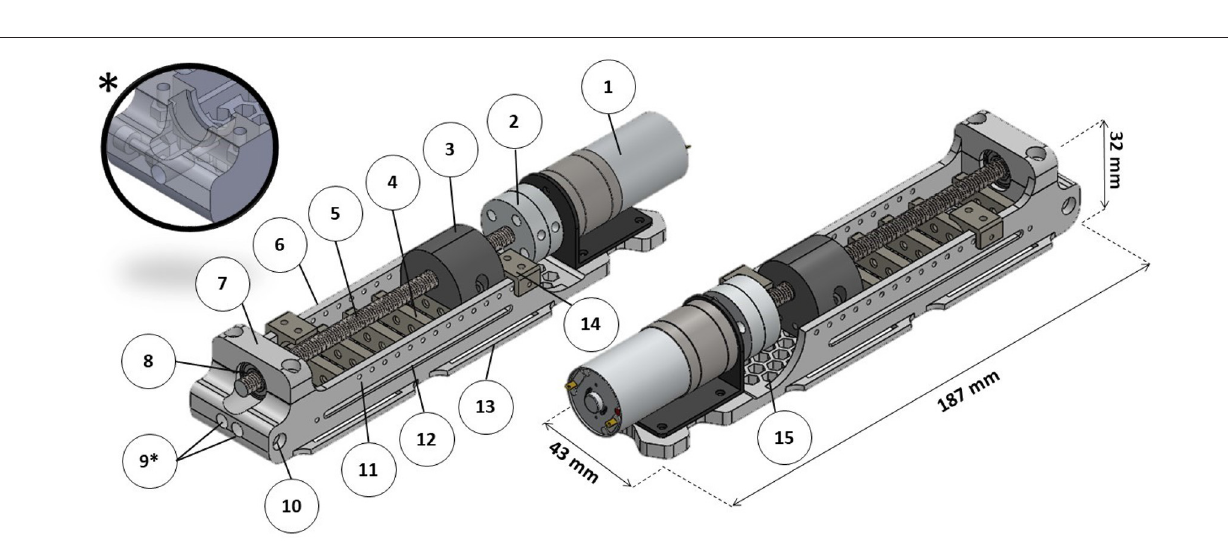
FIGURE 6 | Actuator three-dimensional (3D) model. (1) DC motor; (2) universal couplings for 6 mm (for the lead screw) and 4 mm (for the DC motor); (3) main nut; (4) concertina mechanism; (5) stainless steel M6x1 lead screw; (6) actuator base; (7) bearing mandrel; (8) ball bearing; (9) cable housing entries (*auxiliary view of a model adaptation for use with only one cable); (10) cable housing fixation screw; (11) pin holes to fix micro-switch bases; (12) main nut pins groove; (13) fixation bracket; (14) micro-switch base; (15) honeycomb